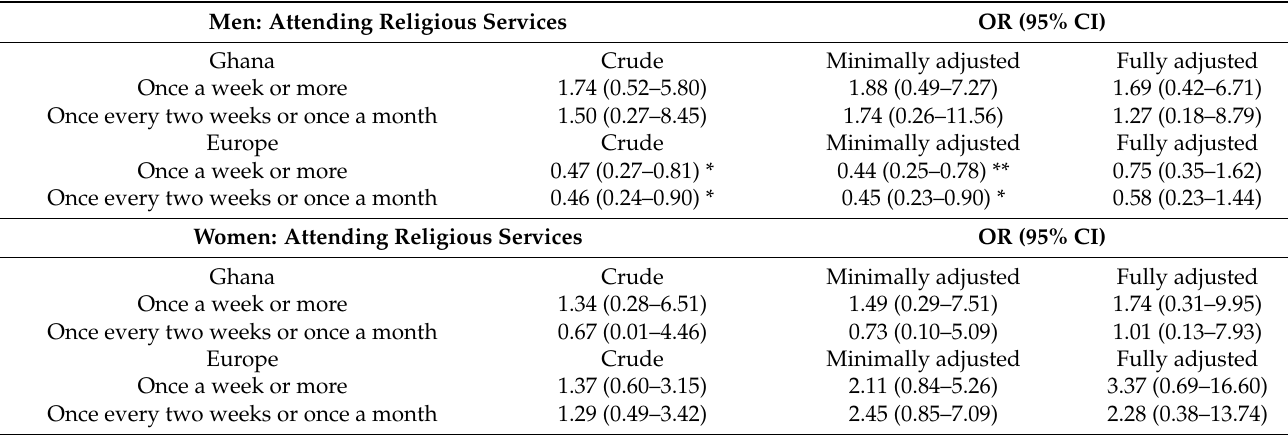
Table 5. Odds ratios for estimated elevated ( ≥ 7.5%) 10-year CVD risk for frequency of attending religious services compared with not attending religious services, stratified for sex and